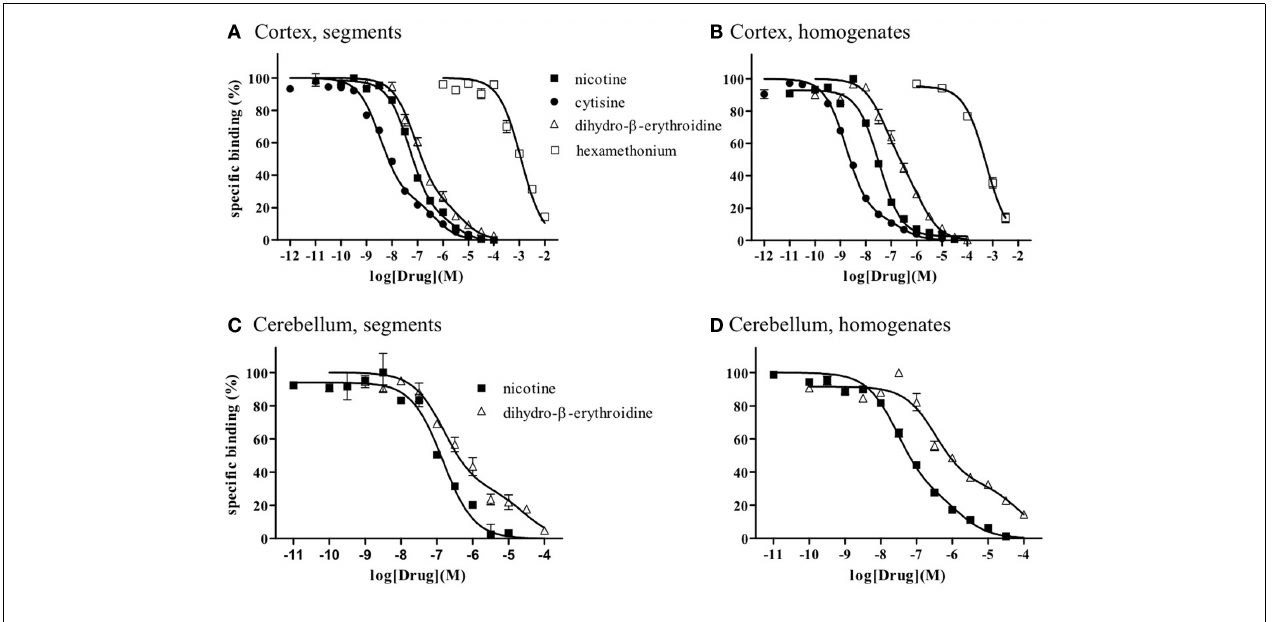
were incubated with 200pM [ (B) : cortex] or 300pM [ (D) : cerebellum] [ 3 H]-epibatidine for 5h at 4˚C. Each point represents the mean of duplicate determinations. Each figure represents four to five experiments.